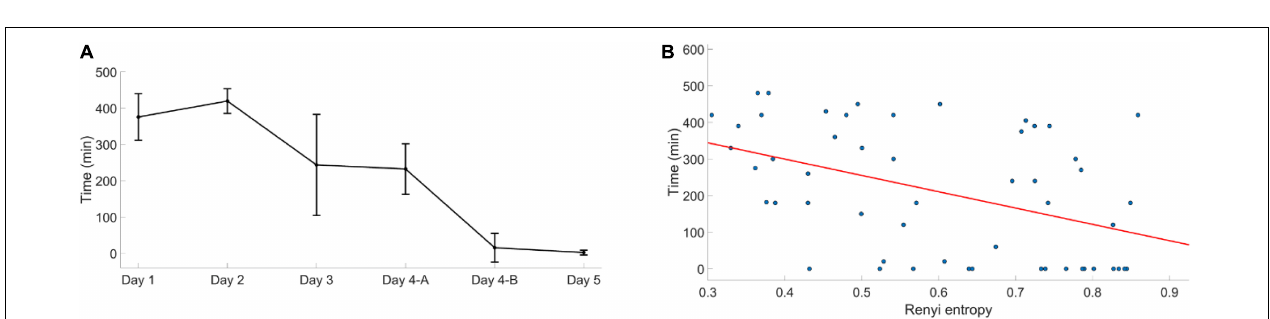
FIGURE 4 | The reaction time for the oddball task and self-rated fatigue for the SSS over six assessment sessions. Error bars indicate the standard deviation. (A) The reaction time for the audio stimulation (blue) and visual stimulation (orange) increased as the competition progressed, and the bars indicate the standard deviation. (B) The self-rated fatigue increased as the competition progressed, and Day 5 is significantly different from the first three assessments. Day 4-A was the first assessment in day four, day 4-B was the second assessment in day four.